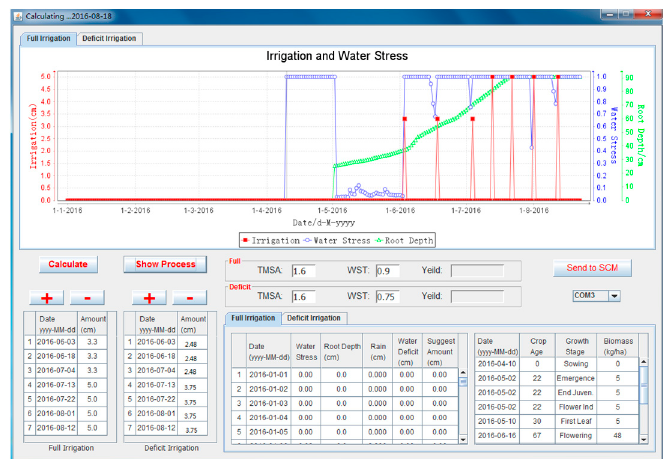
Figure 4. Second user operation interface of IrrSch software.